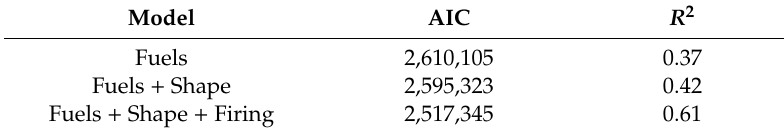
Table 3. Regression models to predict burn severity for the study area (n =